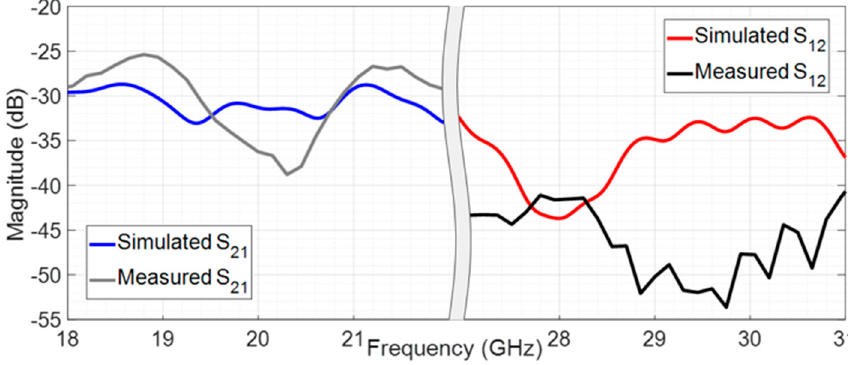
Figure 17. Simulated isolation between two ports.